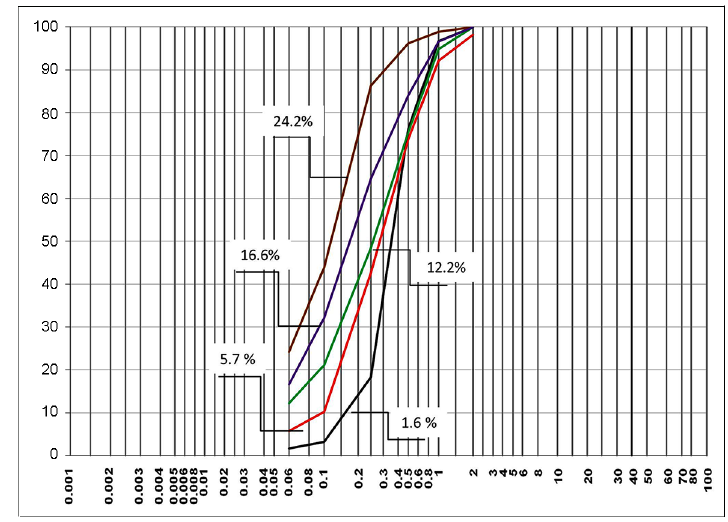
Figure 1. The grading curves of selected